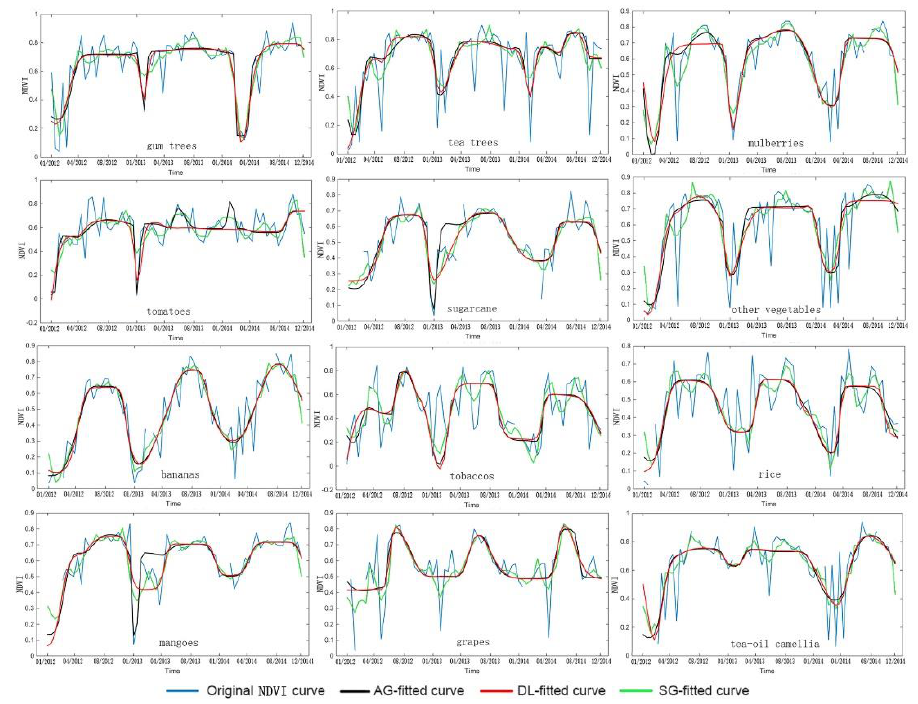
Figure 3. MODIS NDVI time series, and fitted curves using the Savitzky–Golay filter (SG), asymmetric Gaussian (AG), and double logistic function (DL).